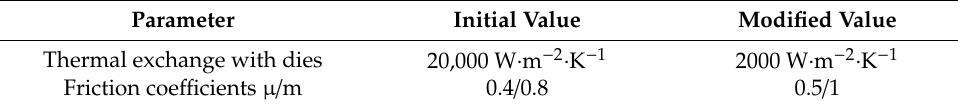
Table 4. FEM modelling parameters used for the parametric